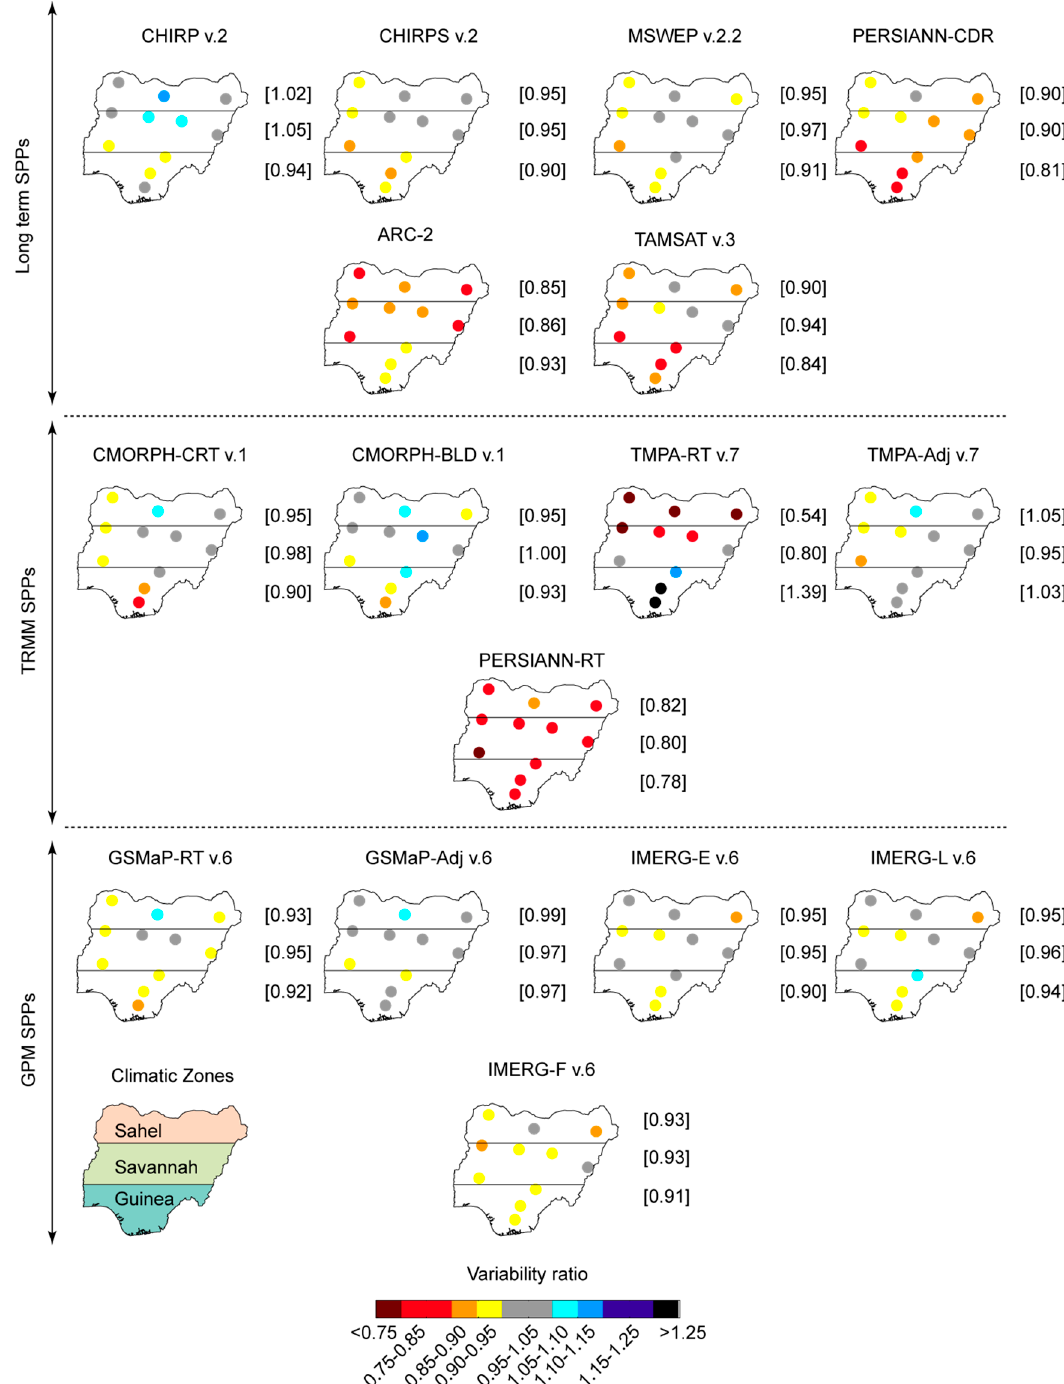
Figure 7. The Vr values obtained at the grid cell level for all SPPs over the 2000–2012 period. The SPPs are grouped according to their respective categories, and the gauges are separated by the country’s ecological zones